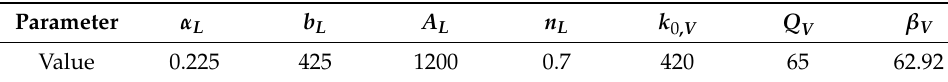
Table 2. Fitting parameters for extrapolated flow curve in simulation